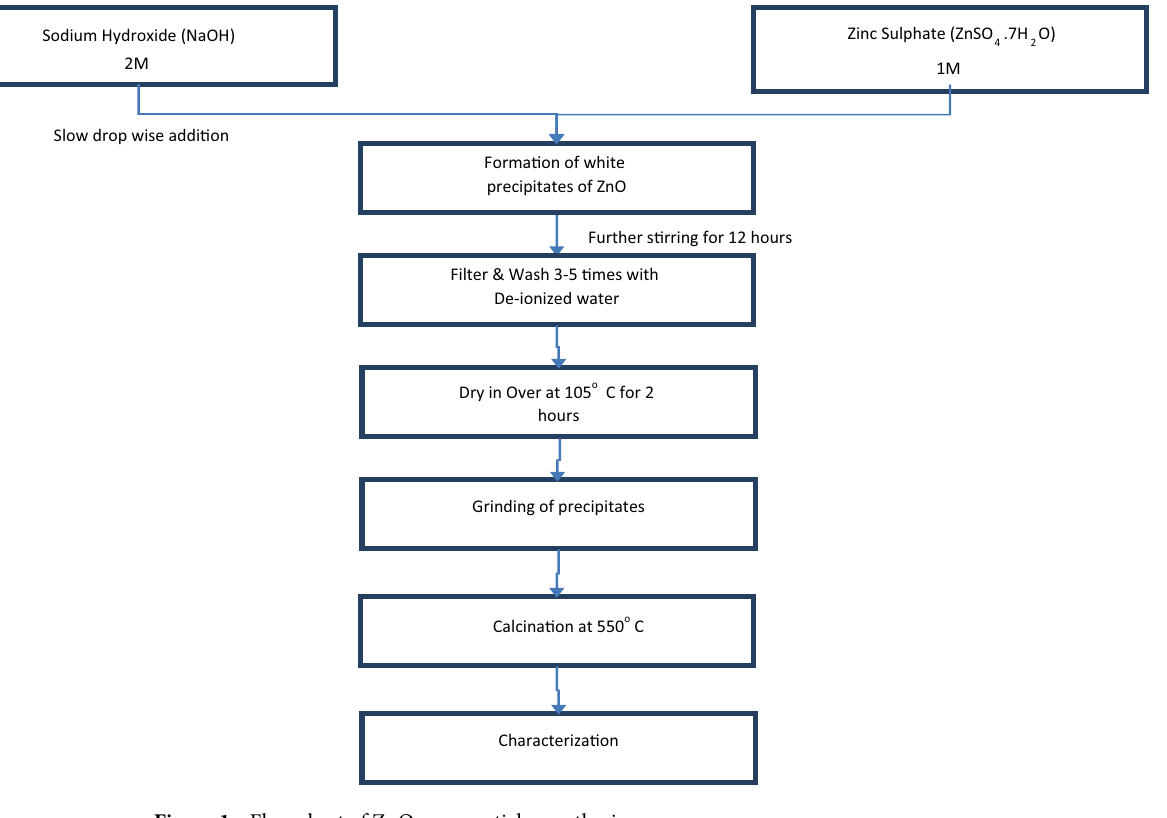
Figure 1. Flow chart of ZnO nanoparticles synthesis.